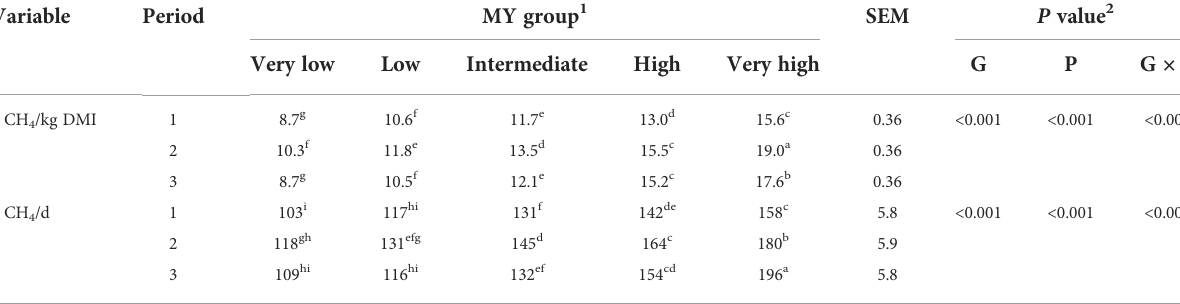
TABLE 3 Methane (CH 4 ) production of heifers by period and CH 4 yield (MY) group.